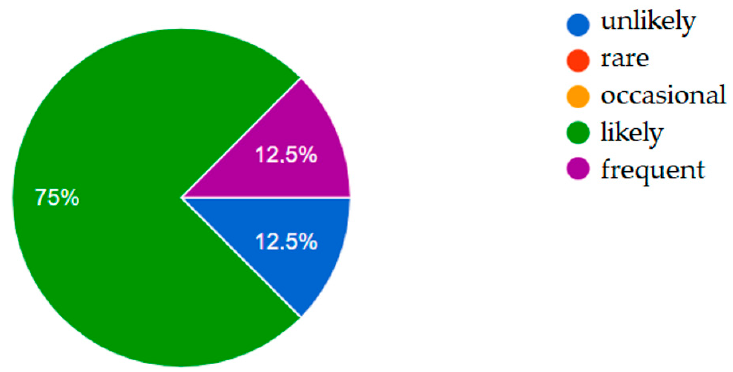
Figure 6. Probability of a disruption in the supply chain.